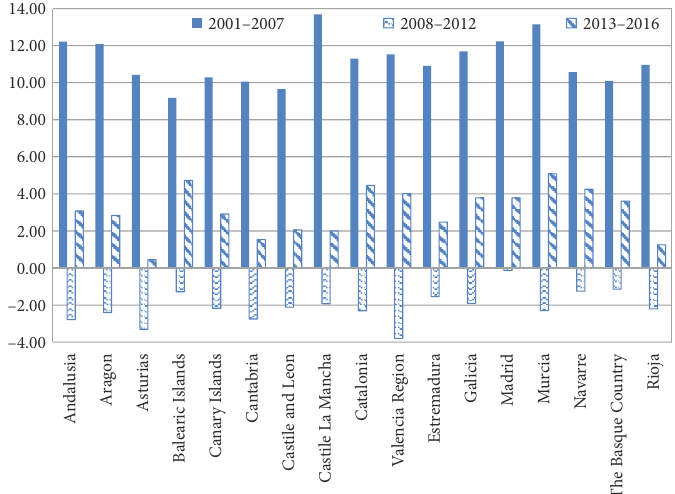
Figure 3. Average growth of GDP (source: compiled by the authors from the INE)